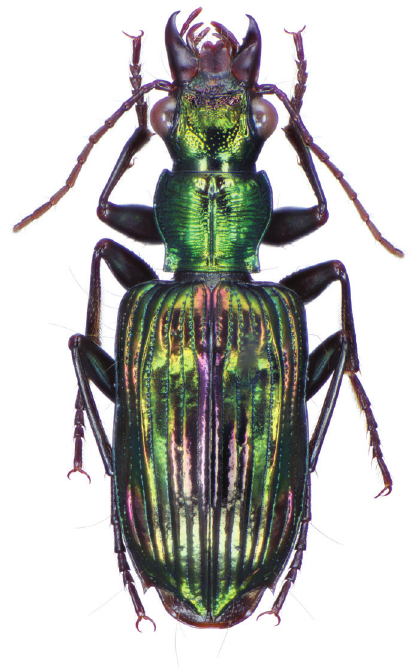
Figure 26. Dorsal habitus and color pattern of Catascopus ( s. str. ) sauteri Dupuis. (OBL 13.13 isodiametric near apex of disc; transverse microsculpture in basal third depression of striae parallel to elytral margins, easily visible at 50× magnification; ventral surface of head with microsculpture transverse, faintly visible at 50×; prosternum, proepipleuron, mesepisternum and metepisternum with sculpticells forming a shallow transverse mesh. Macrosculpture . Dorsum of head rugulose laterally between eyes from basal su- praorbital setae to clypeus, smooth centrally, deep scattered punctation from apical lateral setae to constriction of head, some confluent; pronotum rugulose, several lateral striations from apex to baso-lateral depression, fine scattered punctures throughout; elytra with one impression in basal 1/3 of disc, laterally from basal fixed setae of inter- val 3 to middle fixed setae of interval 3, horizontally from first stria to carina of interval 5; most intervals moderately flat, interval 5 carinate from just beyond basal fixed seta of interval 3 to apical fixed setae of interval 3, interval 7 carinate in basal third, intervals 7 and 8 distinctly carinate and rounded at apical 1/4, disrupting normal contour of elytra; striae punctate along length; ventrally: prosternum, prosternal process, mesos- ternum, mesocoxa and mesosternal intercoxal process, basal portion of metasternum and hind coxa with shallow, scattered, setigerous punctures; abdominal sterna with scattered, shallow punctures. Pilosity . Dorsum of head, pronotum and disc of elytra with scattered micro-punc- tures; ventrally: prosternum, prosternal process, mesosternum, mesocoxa and mesos- ternal intercoxal process and metasternum with short to moderately long, blonde, setae